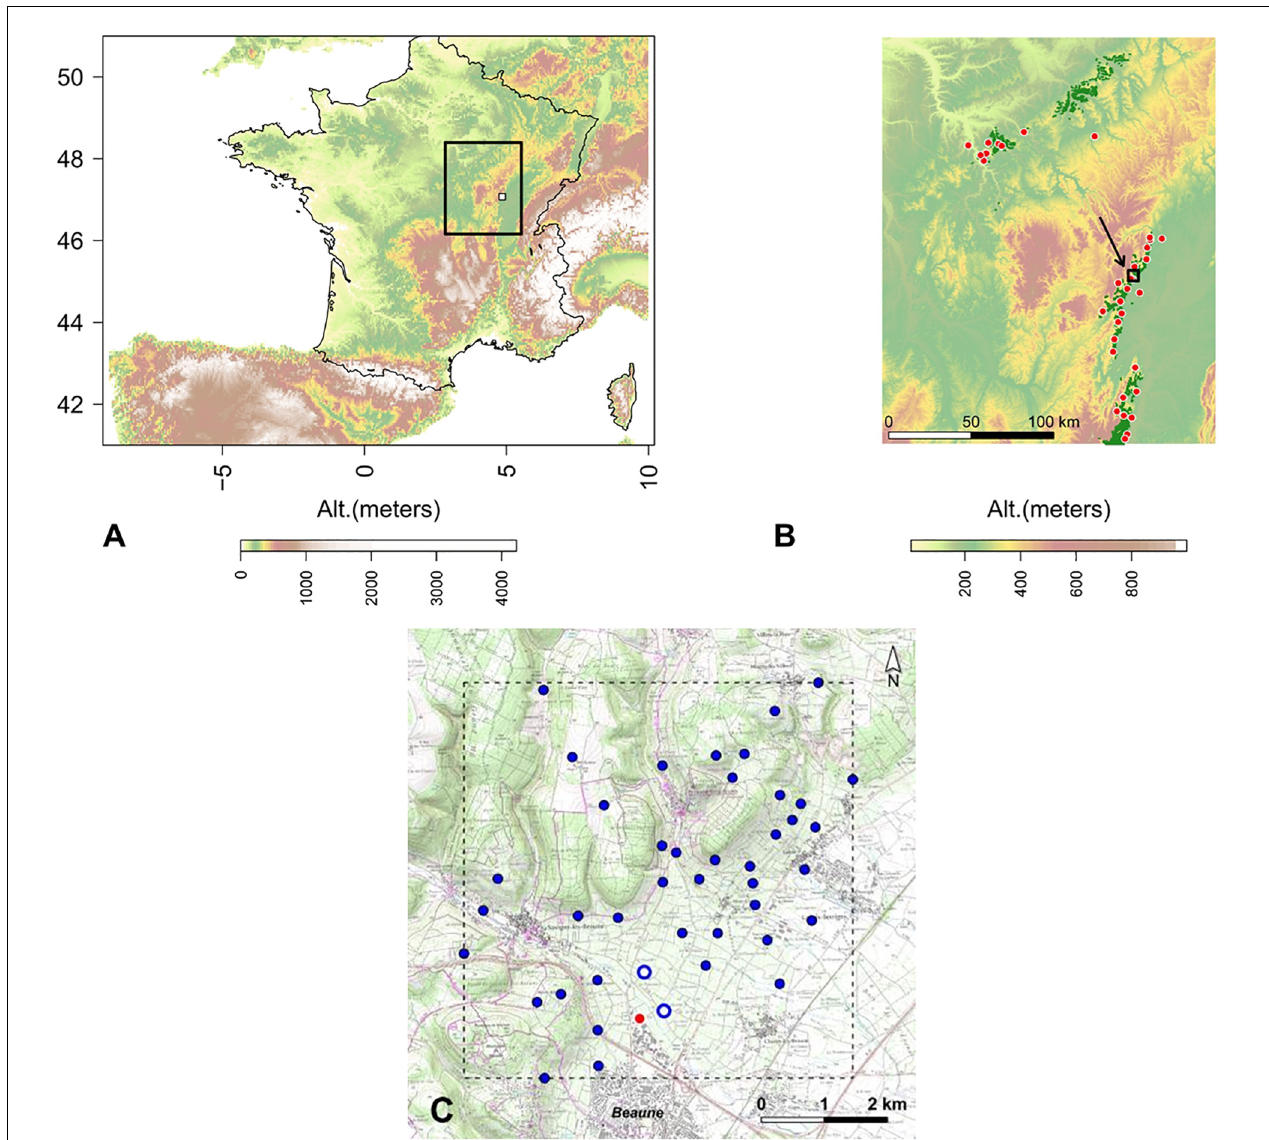
FIGURE 1 | The study area. (A) Burgundy wine region location with coordinates in decimal degrees (black box, zoomed in plot B ); (B) Weather stations locations (red dots). Dark-green areas correspond to vineyards. The Hydravitis network location is indicated by a black square pointed by the arrow; (C) the Hydravitis high-resolution rain gauges (blue dots) network. White-filled blue dots correspond to location where two rain gauges were installed aside. The red dot shows the location of the Beaune weather station (Climeo mesoscale network).